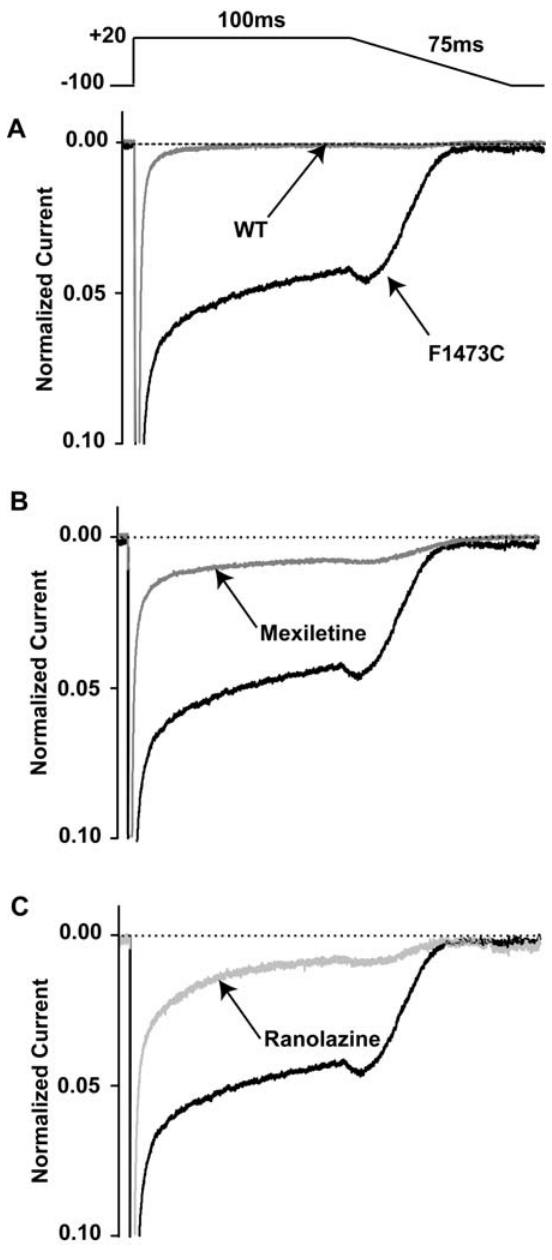
Figure 7. Mexiletine and ranolazine inhibit F1473C channel activity during repolarization. Inward currents were measured in response to a pulse to + 20 mV for 100 ms followed by repolarization to 2 100 mV at 2 1.6 V/sec (negative ramp) (see Methods S1). A. F1473C channels, relative to WT channels, show a very large increase in non-inactivating current for the duration of the voltage pulse to + 20 mV and also cause a large surge of inward current during the negative voltage ramp. B–C. Mexiletine (B) and ranolazine (C) inhibit the mutation-induced repolarizing inward current (Mexiletine block of repolarization phase peak current=82.1 + / 2 0.2%, n=7; Ranolazine block of repolarization phase peak current=83.1 + / 2 0.2%, n=4).